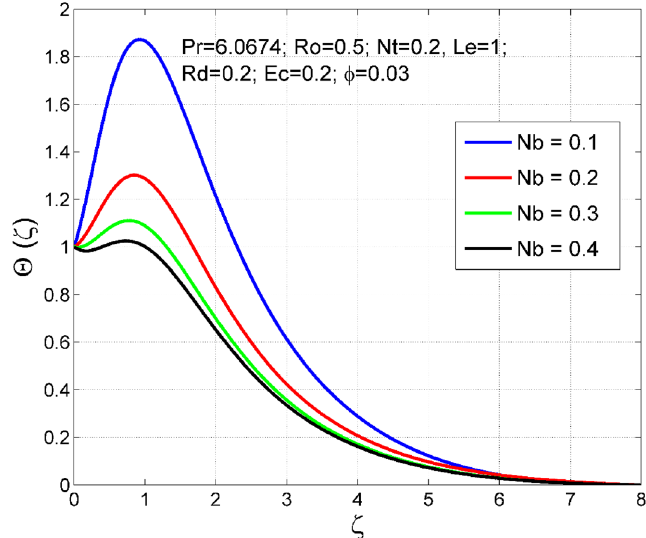
Figure 7. Effect of Nb on �(ζ) .